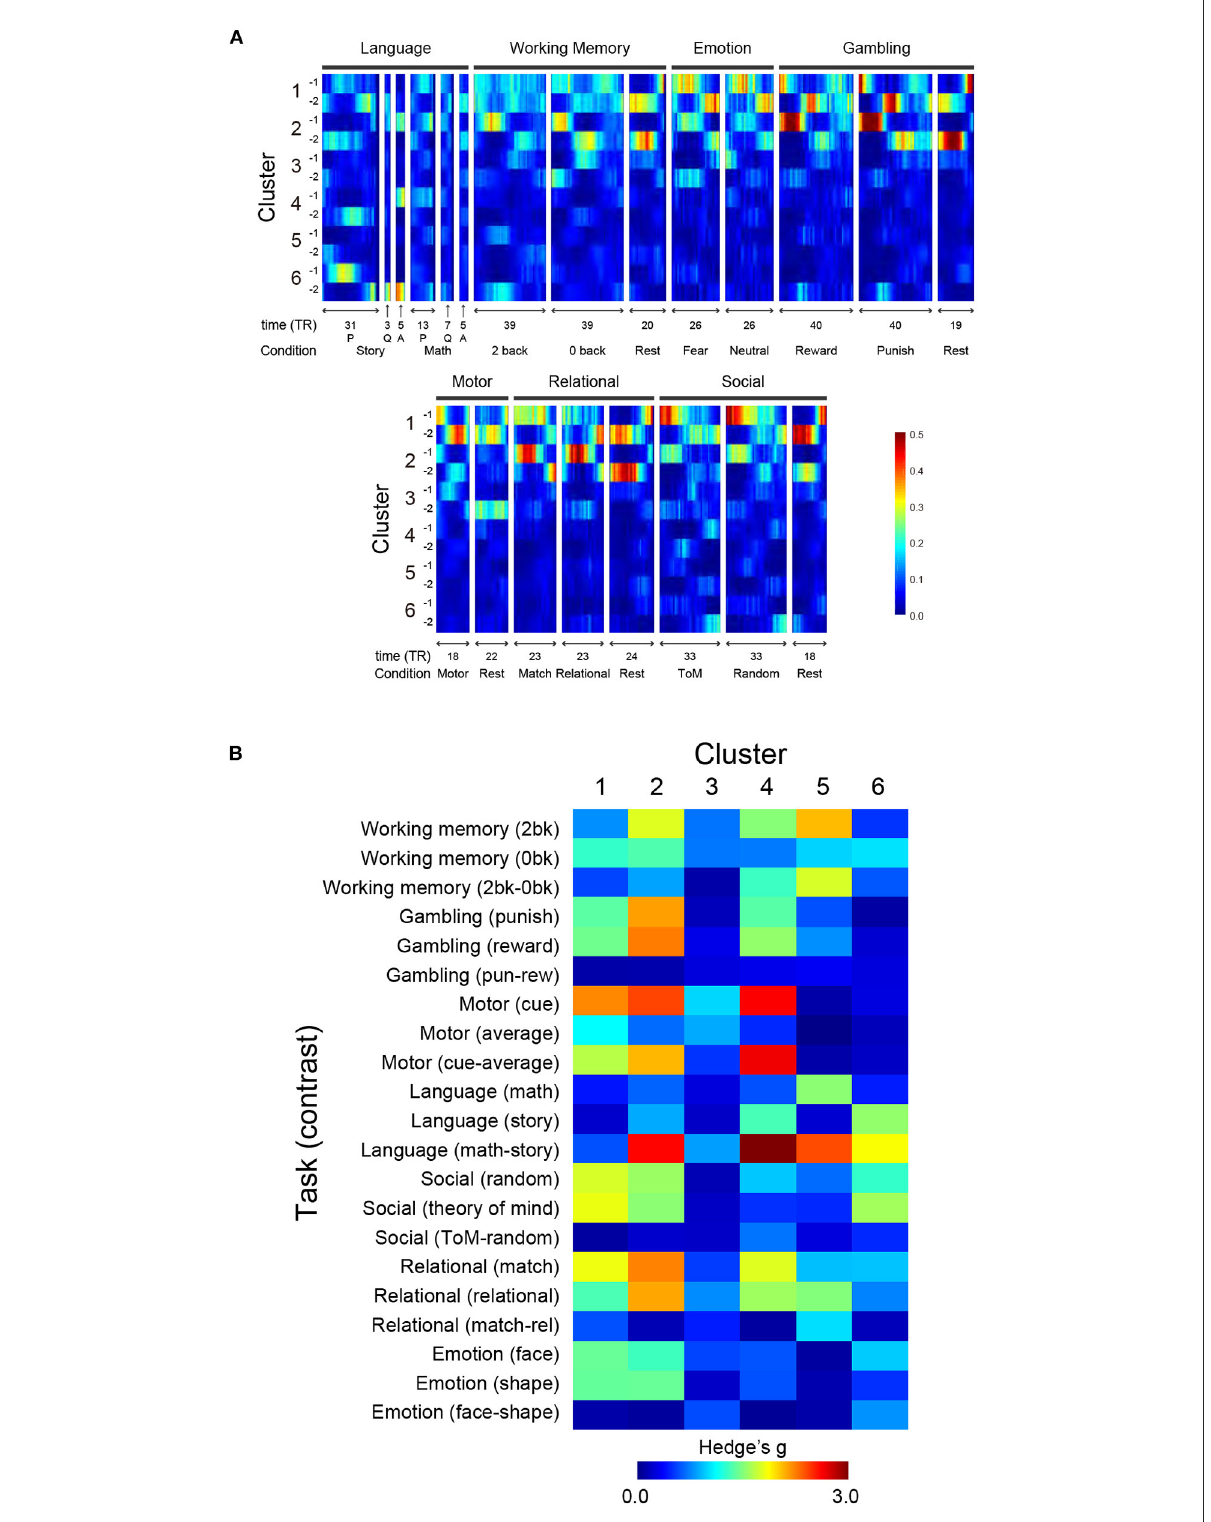
FIGURE5 Relationships of TSP in resting state and task states. (A) TSPs during performance of the 7 tasks were classified using a classifier trained on resting-state data, and classification scores of the task-TSPs were calculated along task blocks. For each cluster and scanning frame, scores are color-coded as shown at the bottom right. For language tasks, P and Q denote presentation onset of problems and questions for story/math trials, respectively, and A denotes response onsets. (B) Spatial consistency of TSPs between during resting state and task performance. Spatial consistency was calculated as correlation indexed by Hedges’ g between TSP maps. The effect size of Cluster N-1 and N-2 was averaged and then color-coded on the heat